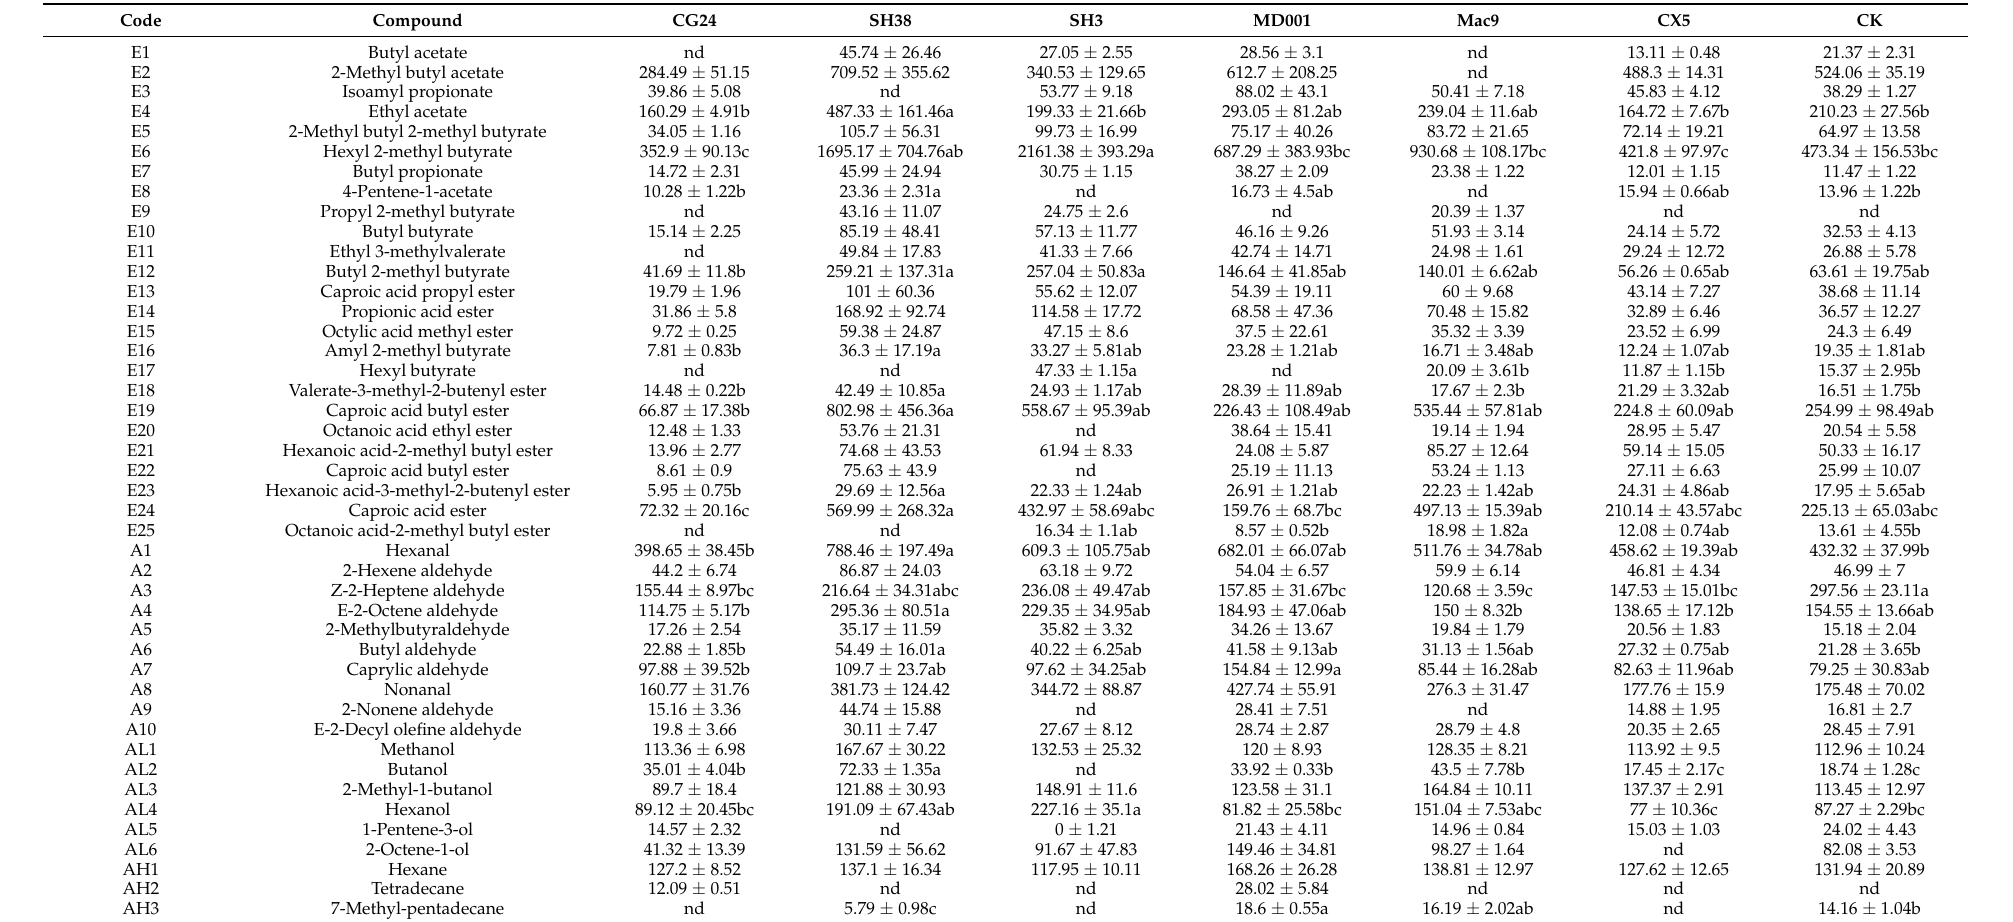
Table 2. Average content and standard error (mean ± SE; n = 3) of VOCs in skin of ‘Huahong’ apples ( µ g/kg) grown from different dwarf interstocks (CG24, SH38, SH3, MD001, Mac9, CX5) as determined by